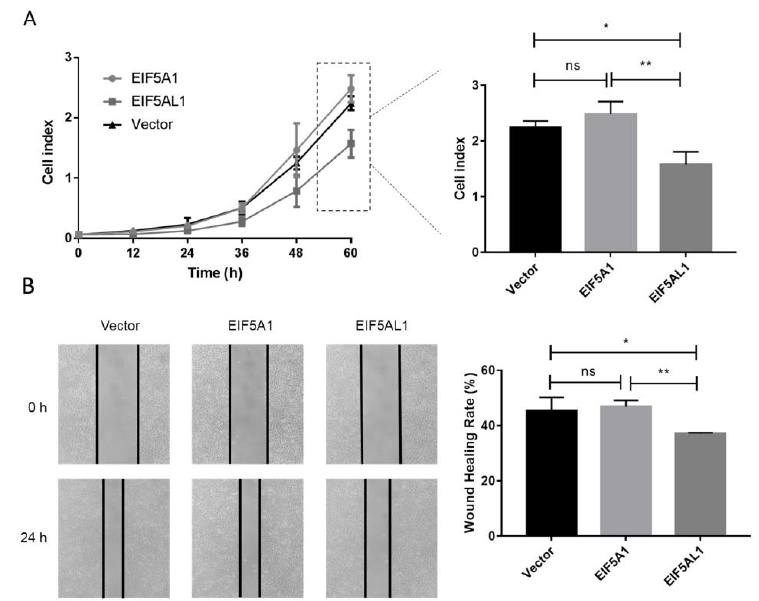
Figure 2. Overexpression of EIF5AL1 affects the proliferation and migration of HeLa cells. After transfecting and expressing EIF5A1, EIF5AL1, and vector plasmids in HeLa cells, respectively. ( A ) HeLa cells were seeded on 16-well E-plates with 3.0 × 10 3 cells in each well and incubated in a cell incubator for 60 h and tested for cell index values over time. ( B ) HeLa cells were seeded into 12-well plates with 3.0 × 10 5 cells per well for 24 h, and then, a wound healing assay was performed. ns, p > 0.05; *, p ≤ 0.05; **, p ≤ 0.01. 2.2. Three Amino Acid Differences Exist between EIF5A1 and EIF5AL1 Through the UniProt database, we found that both the EIF5A1 and EIF5AL1 proteins are composed of 154 AA residues, and their difference is only by three AAs, at positions 36, 45, and 109, respectively (Figure 3A). Thus, we further investigated why overexpres- sion of EIF5A1 and EIF5AL1 proteins exhibited differential effects in HeLa cells.